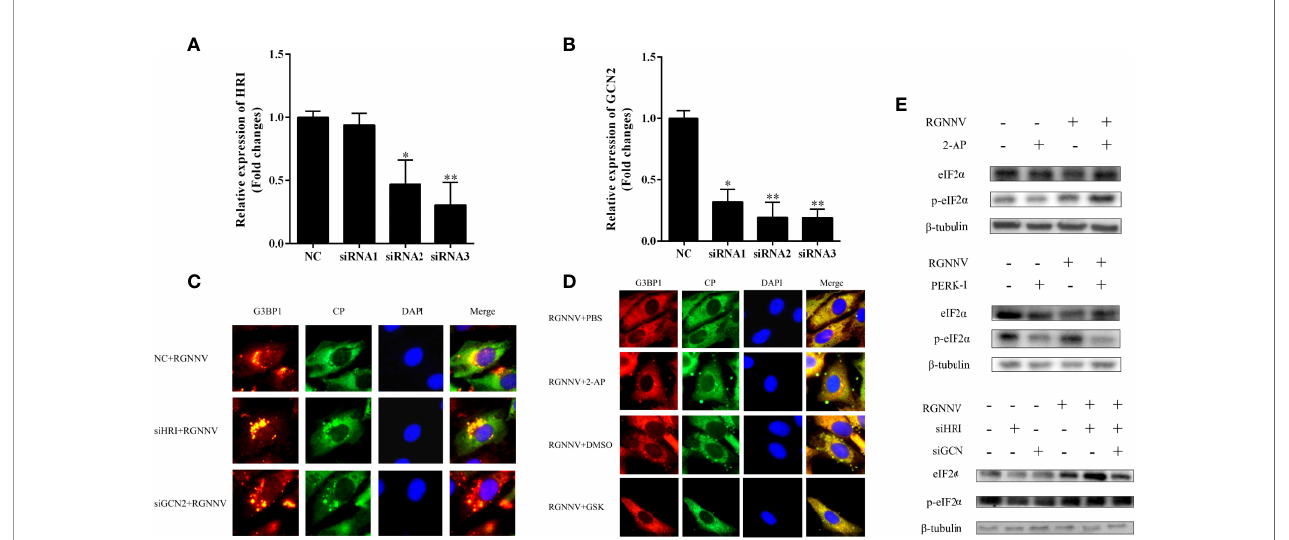
FIGURE 3 | RGNNV infection produced SGs through the PERK pathway. (A, B) The knockdown ef fi ciency of siHRI or siGCN2 in GS cells. siHRI and siGCN2 or si- control were transfected into GS cells. After 36 h, the mRNA levels of siHRI and siGCN2 were determined by qRT-PCR. b - tubulin was the internal reference. (C) GS cells were transfected with si-control and siHRI or siGCN2 and then infected with RGNNV at 36 h post-transfection. The cells were fi xed and stained with anti- G3BP1 antibodies and anti-CP antibodies. (D) The cells were treated with DMSO, 2-AP, GSK, or PBS for 1 h, and the medium was changed, and the cells were inoculated with RGNNV for 4 h, and the medium containing DMSO, 2-AP, GSK, or PBS was changed again. (E) The phosphorylation level of eIF2 a was detected at the protein level. After GS cells were treated with 2-AP or GSK inhibitors or transfected with siHRI and siGCN2, RGNNV-infected cells were phosphorylated. The phosphorylation expression of eIF2 a was detected by western blot. *p < 0.05, **p <